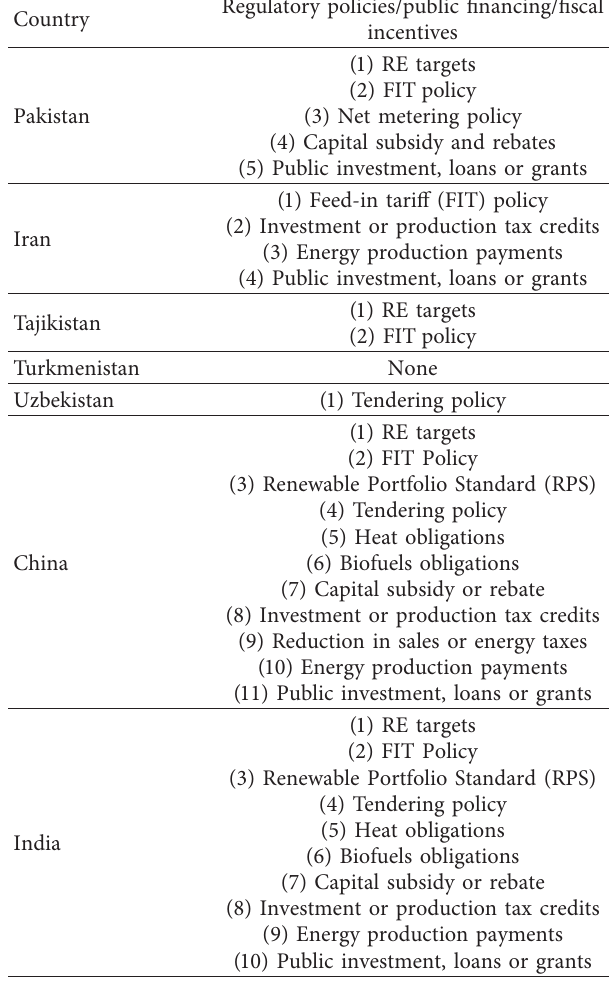
Table 2: Policies and financing mechanisms adopted in Afghanistan neighboring countries and India as of the end of 2013